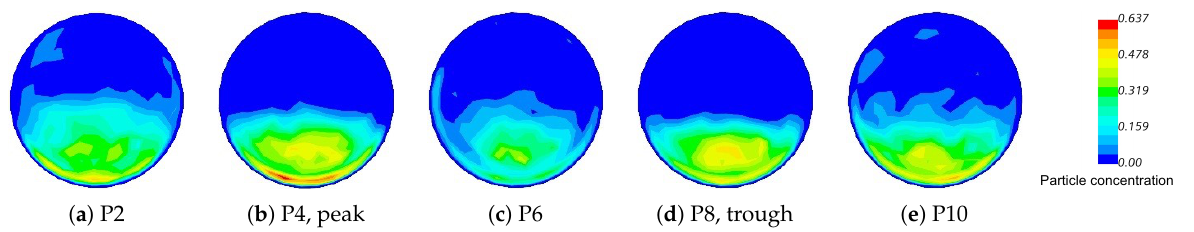
Figure 9. Particle concentration in the cross sections of the typical